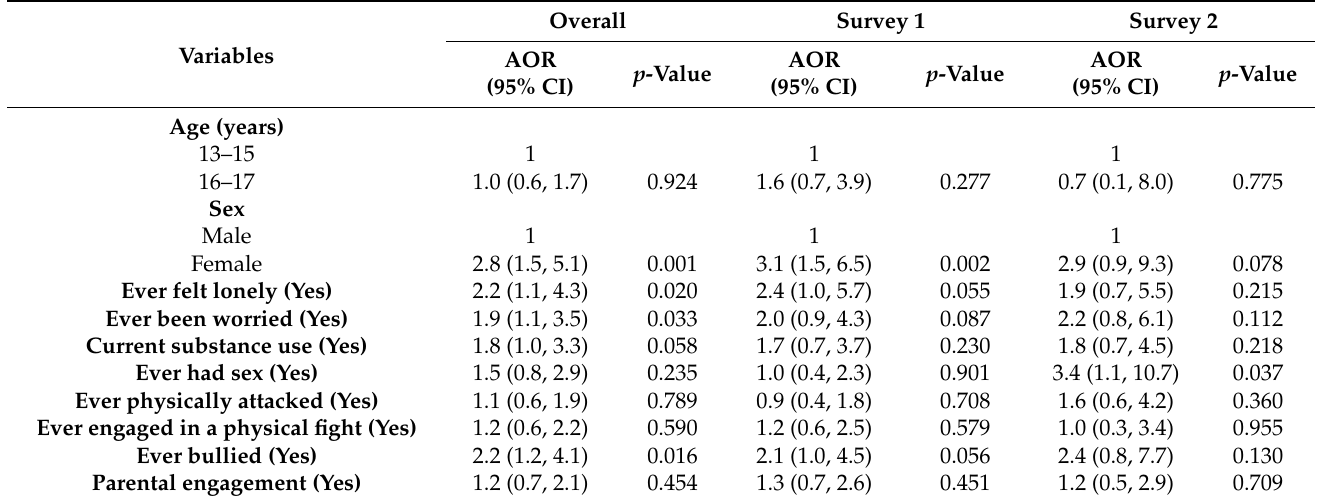
Table 3. Analysis of factors associated with suicidal attempts among secondary school-going adoles- cents from two repeated RSHS in 2019 and 2022 in Kilimanjaro region, northern